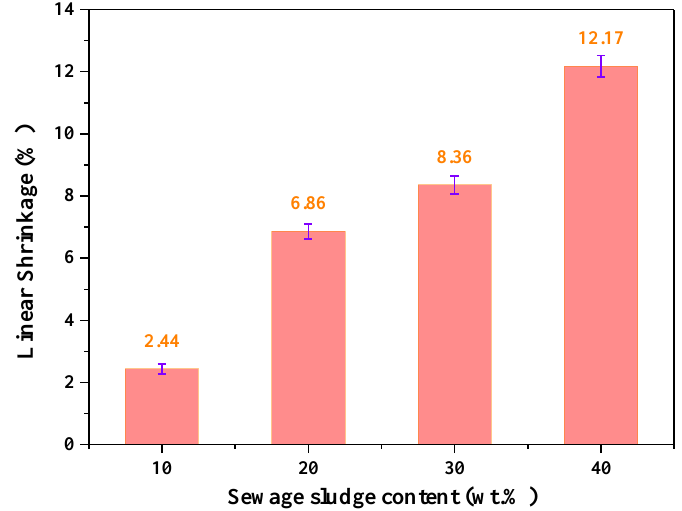
Figure 4. Apparent density of the ceramic bricks with various sewage sludge contents.